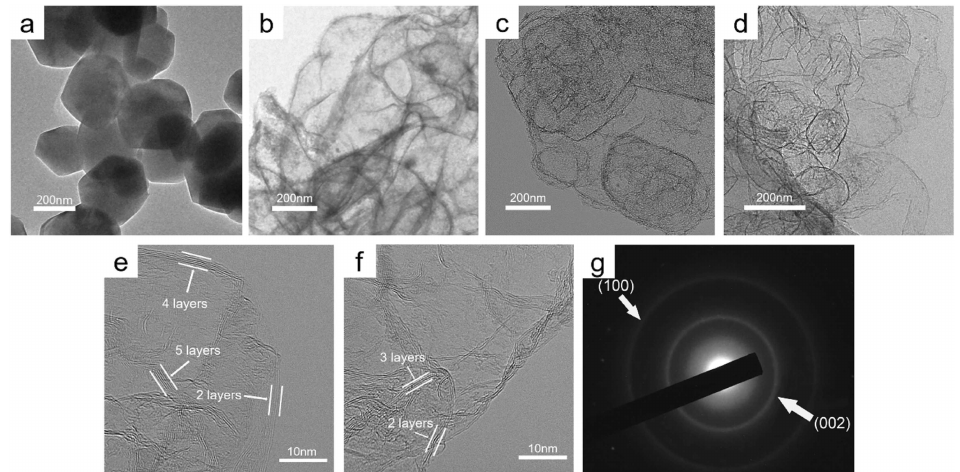
Figure 12. TEM images of ( a ) MgO template, ( b ) SHS-4, ( c ) SHS-8, ( d ) SHS-10, HR-TEM graph of ( e ) SHS-8, ( f ) SHS-10, and ( g ) selected area diffraction (SAED) pattern of SHS-8. Samples labelled SHS-n according to the mass ratio of Mg/MgO in the self-propagating high temperature combustion synthesis samples, which is 1:4, 1:8 and 1:10, respectively. Reprinted with permission from Ref. [58]. 2022,